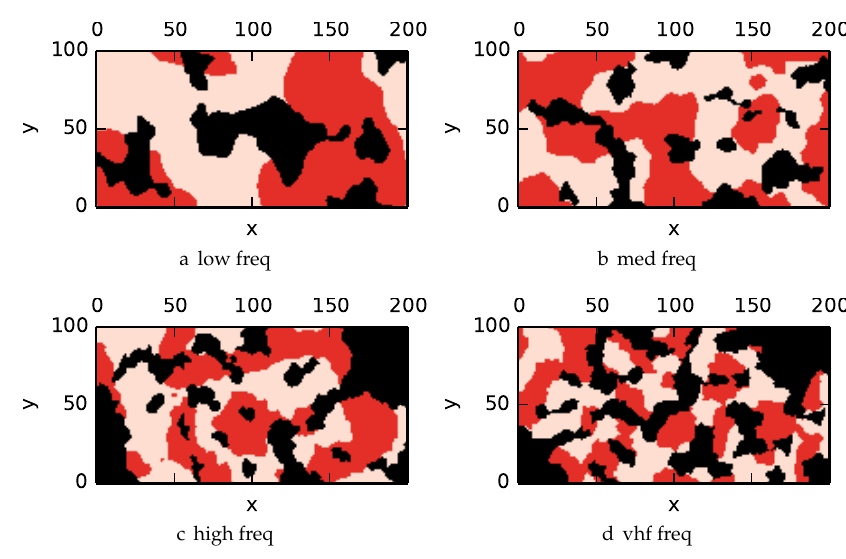
Figure 15. Example nonuniform environments showing obstacles (black), and the entropy of the cells before the search. The dark red indicates high entropy regions while the light red indicates low entropy regions.